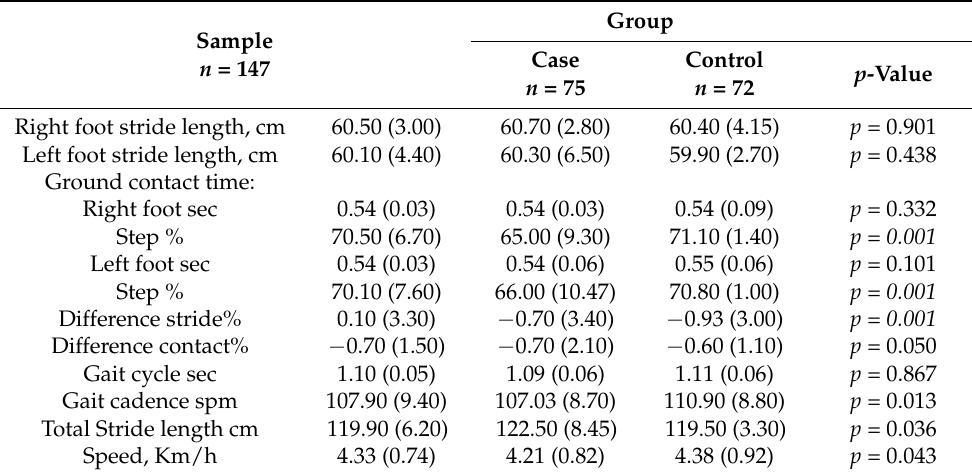
Table 2. Descriptive statistical analysis after the OptoGait sensor gait analysis between the control and case